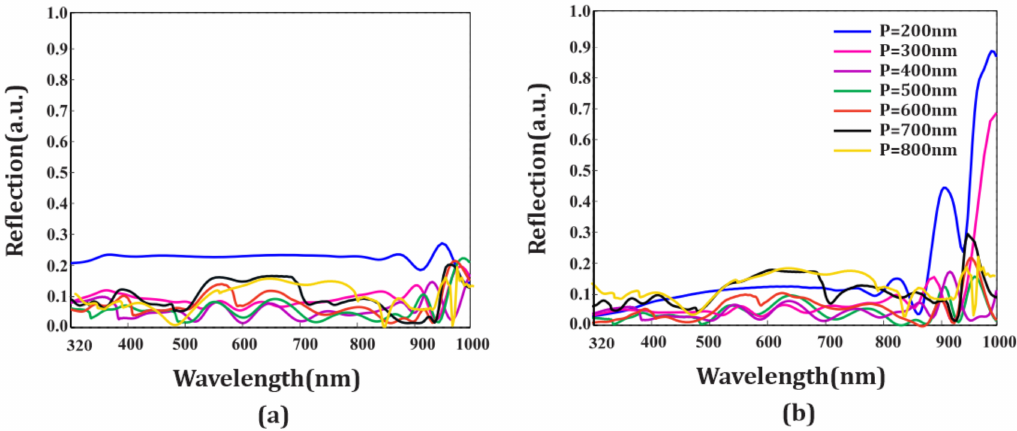
Figure 10. Reflection spectra for varying pitch for ( a ) bare cell and ( b ) proposed